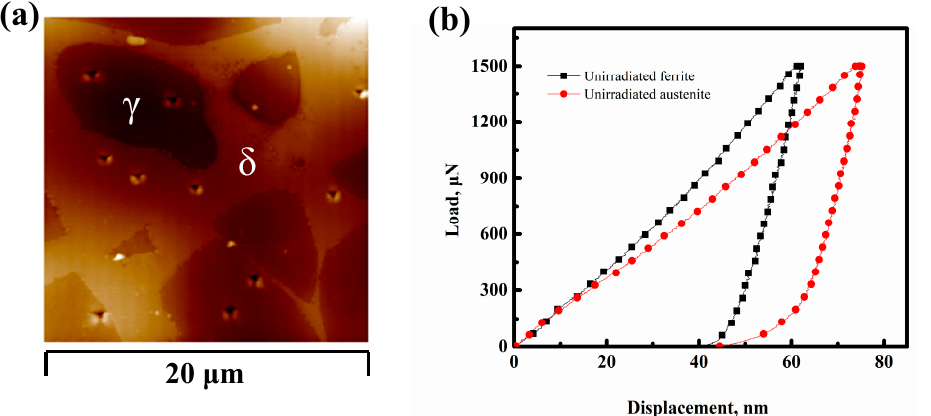
Figure 2. ( a ) SPM surface topography of unirradiated austenite and ferrite phases; and ( b ) nanoindentation load-displacement curves of the two phases in ( a ).